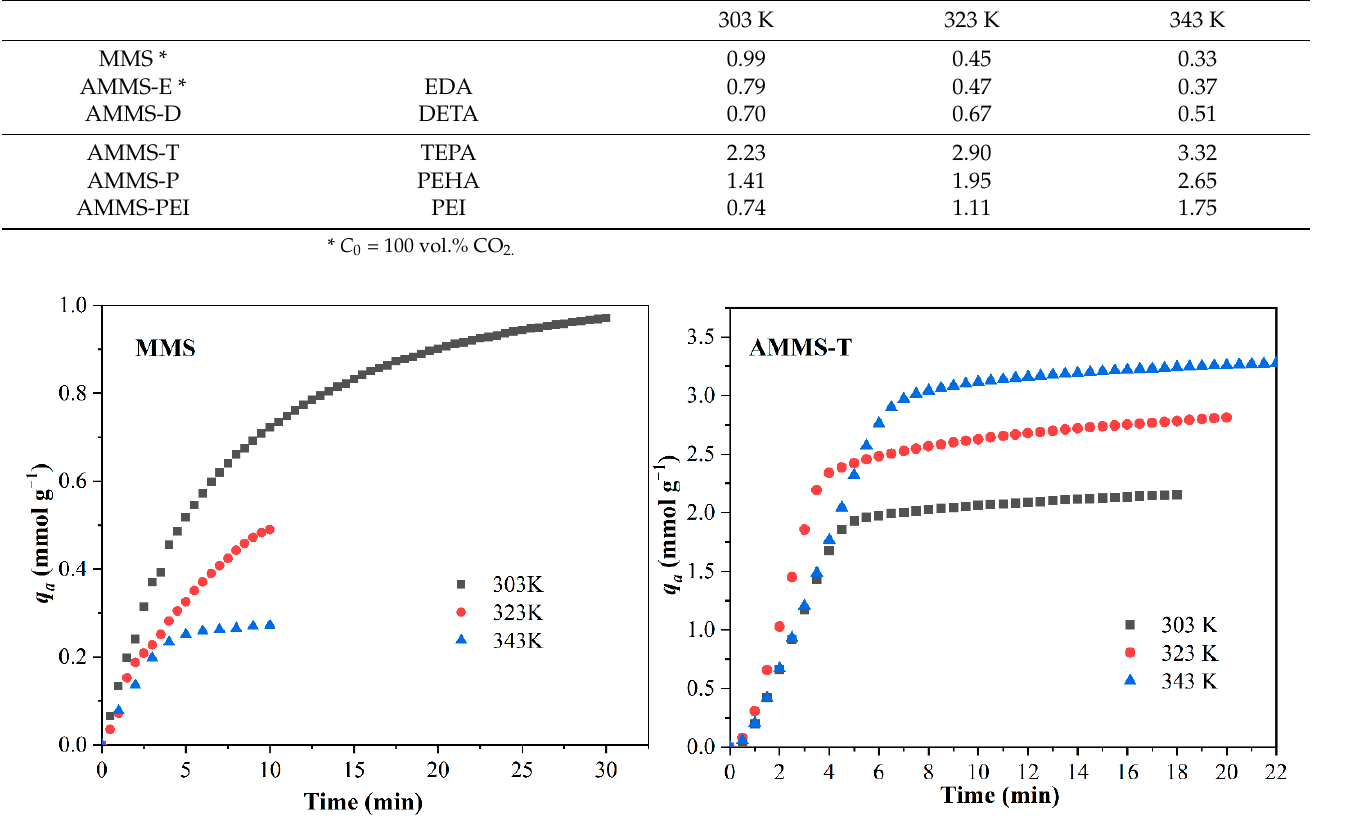
Figure 6. CO 2 Adsorption curves of MMS and AMMS-T at 303 K, 323 K, and 343 K.